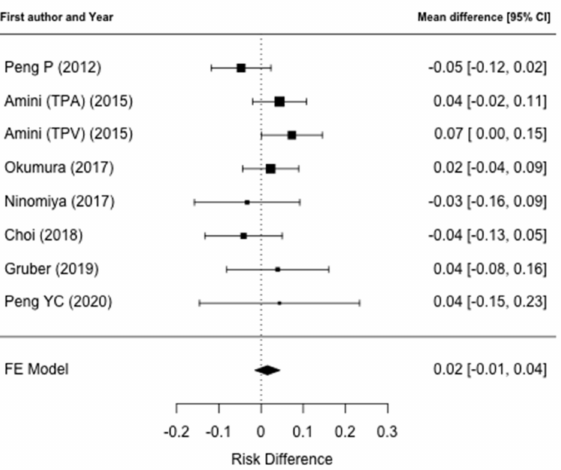
Figure 4. Forest plot for the difference in the prevalence of major complications. The difference in prevalence of major complications in patients with vs. without low muscle mass was not significant.